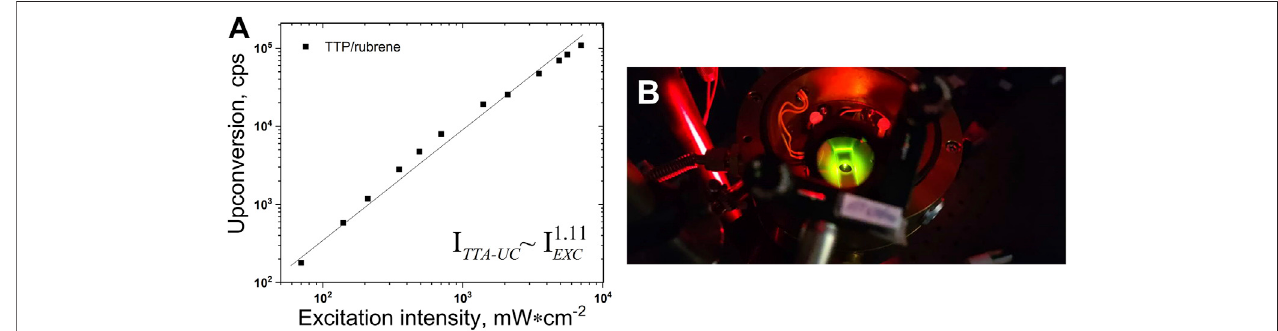
FIGURE 4 | (A) – Dependence of the UC intensity on the excitation intensity. Experimental conditions : UC couple, TTP (2 × 10 -5 M)/rubrene (4 × 10 -4 M); ratio sensitizer/emitter - C S /C E = 1/20; room temperature; sample thickness – 1000 μ m; single-mode laser diode, λ exc = 658 nm; optical registration – via fi ber – spectrometer (C10083CA, Hamamatsu Inc.) with absolute wavelength calibration and corrected spectral response; integration time, 100 ms; excitation beam diameter, d EXC = 1600 µm;Vitrotube ® glasssample,sealedinanitrogen- fi lledglove-box,residualoxygen < 2ppm;eachmeasurementisperformedonaneatsamplespot;solvent, 98vol%toluene/2vol%squalene; Q.Y. TTA-UC =0.018(followingtheIUPACde fi nition). (B) – Photographofaworkingmetal-freeTTA-UCsample.Inordertosuppressthe diffuse scattered excitation light, a super broadband notch fi lter was